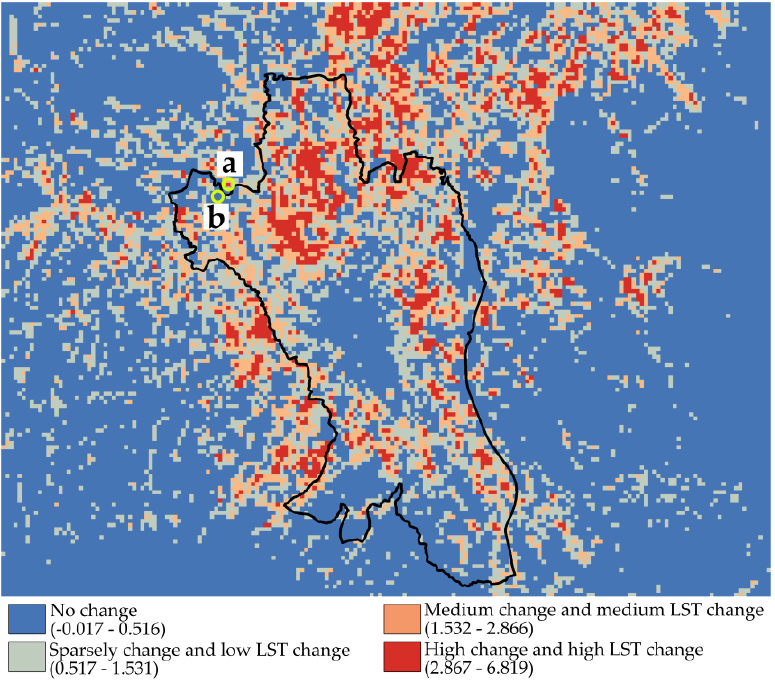
Figure 15. Map of high change area. The black line indicates the boundary of the Bogor City. Points (a and b) show the location of photos in Figure 16.